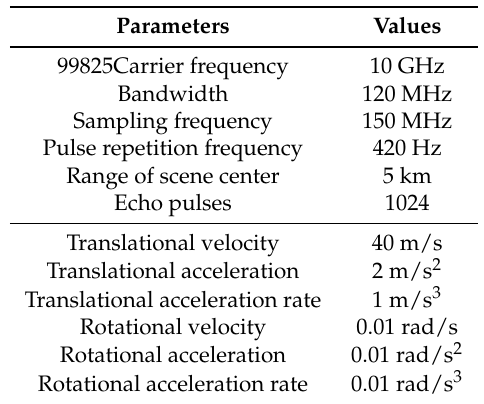
Figure 7. Contour plots and azimuth profiles of PT 1, PT 2 and PT 3. ( a , e , i ) Contour plots of PT 1, PT 2 and PT 3 based on the ISAR algorithm, respectively. ( b , f , j ) Azimuth profiles of PT 1, PT 2 and PT 3 based on the ISAR algorithm, respectively. ( c , g , k ) Contour plots of PT 1, PT 2 and PT 3 based on BEFRFT, respectively. ( d , h , l ) Azimuth profiles of PT 1, PT 2 and PT 3 based on BEFRFT, respectively. Table 1. Parameters of radar system and ship target.